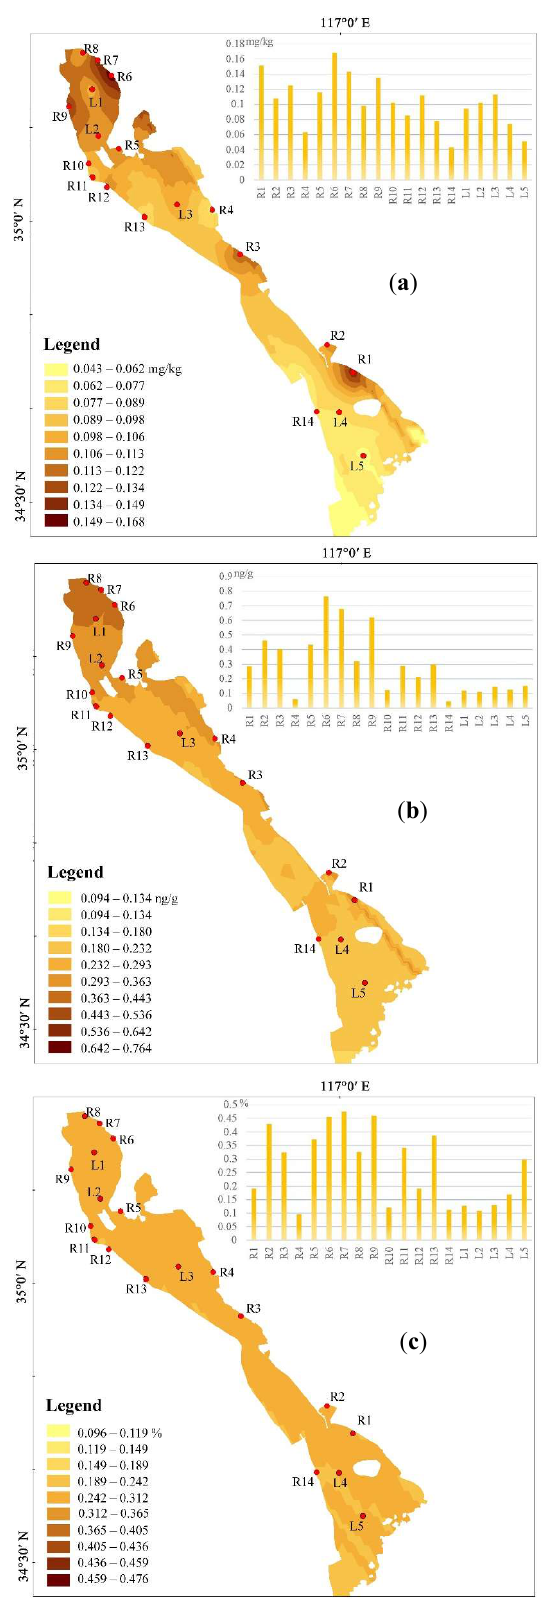
Figure 4. The spatial distribution of ( a ) total mercury (THg), ( b ) methylmercury (MMHg), and ( c ) methylation rate (%MMHg) in the estuarine and lake